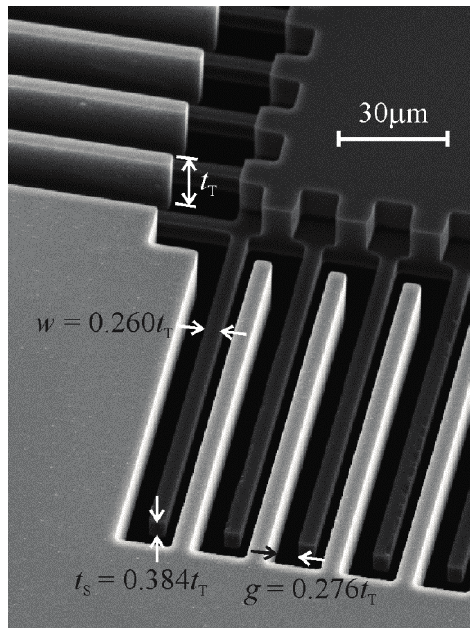
Figure 6. The relative tooth dimensions of one of the vertical comb drives fabricated for this